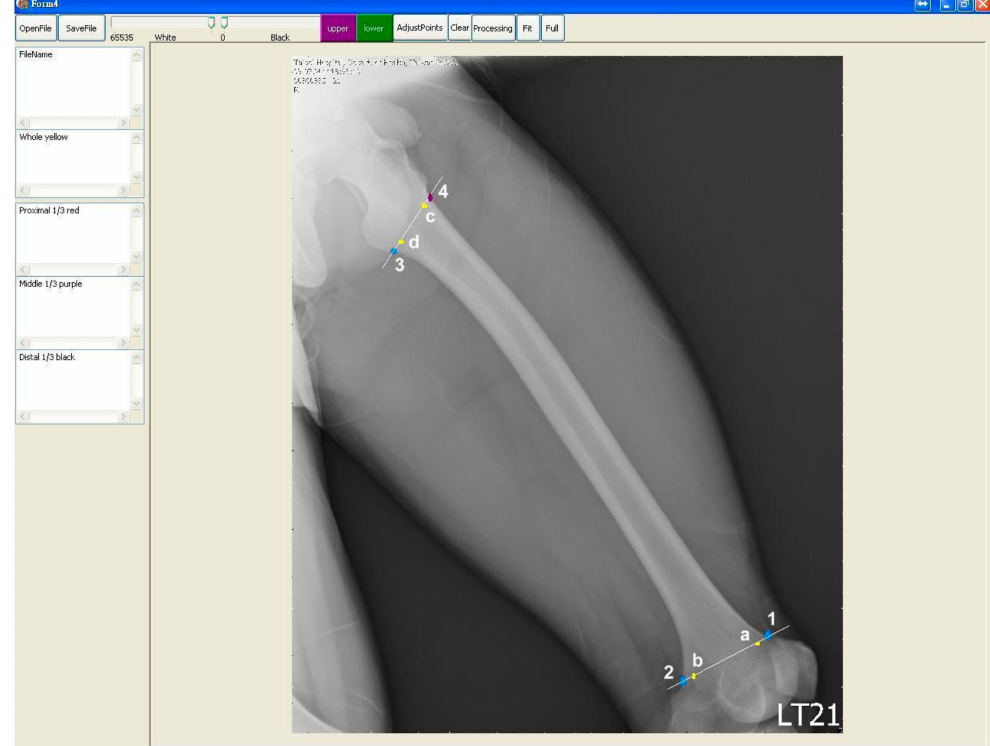
Figure 3. Blue points 1 and 2 were marked as the distal ends of cortical border (femoral shaft outline). Blue point 3 was marked below the lesser trochanter. Purple point 4 was determined on the other side. Both points 3 and 4 were the proximal ends of cortical border. The 4 yellow points were the distal and proximal ends (a, b and c, d) of borders of the medullary